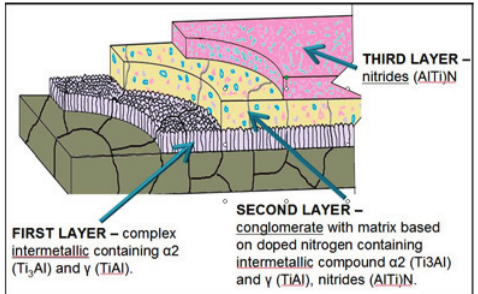
fig. 1. The structure of the heat-resistant nanocoating The first inner intermetallic layer based on titanium aluminide is used to create a diffusion bond between the coating and base material. It is a complex intermetal- lic compound containing α2(Ti3Al) and γ(TiAl). This layer may contain up to 60% aluminium with the basic structure of intermetallic maintained. Unfortunately, heat-resistance above 700 °C of intermetallic compounds is limited, and the use of this type of coating without ad- ditional protection is not very effective.